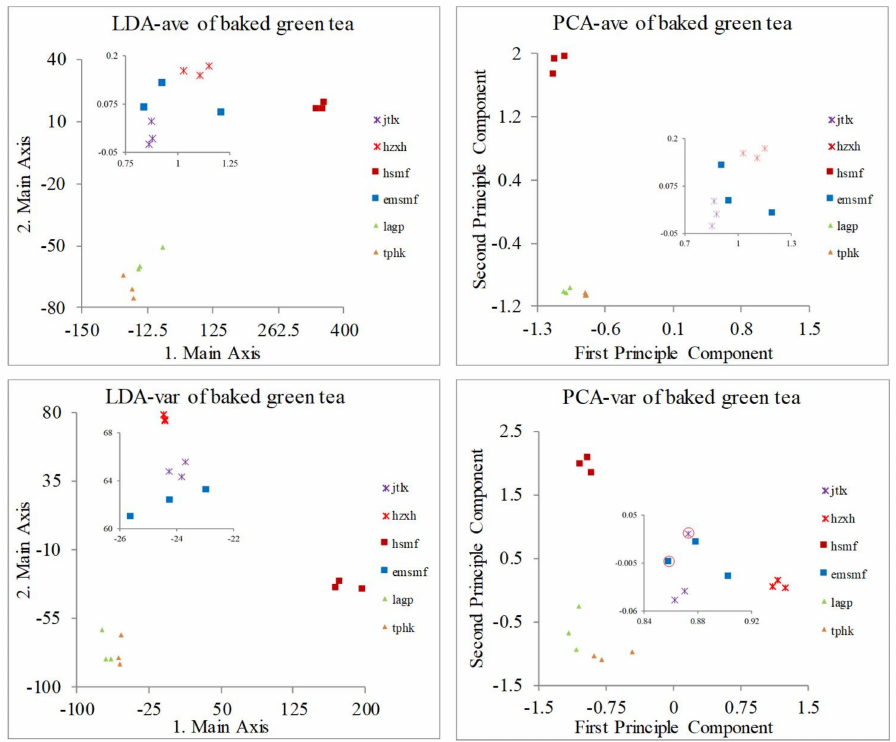
Figure 12. Classification results of baked green tea identified using LB. When LDA-ave +NNC are used, satisfactory results are obtained. The discrimination accuracy of LG for 12 kinds of green tea, LF for 6 kinds of faked green tea and LB for 6 kinds of baked green tea can almost reach to